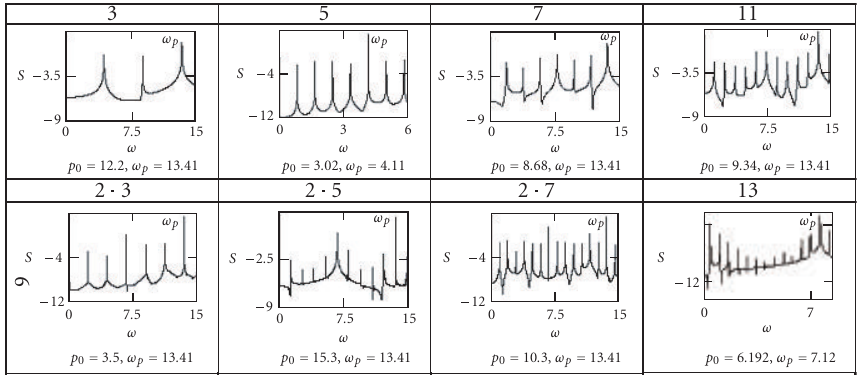
Table 3.2. Power